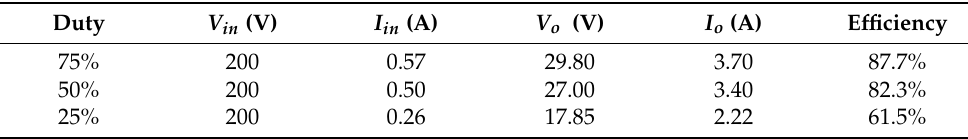
Table 4. S-PWM operation mode efficiency